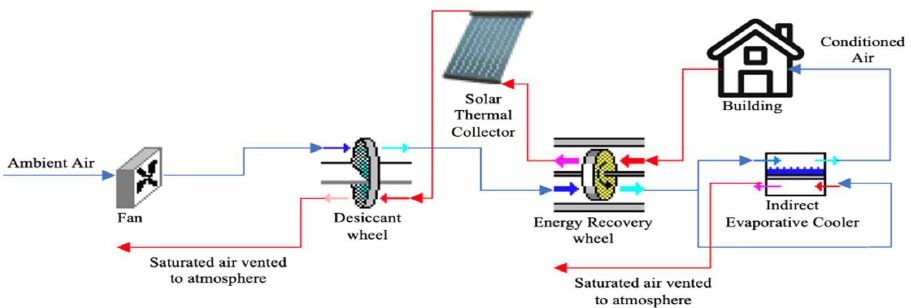
Figure 3. Proposed system using conditioned air from building to regenerate the desiccant wheel.